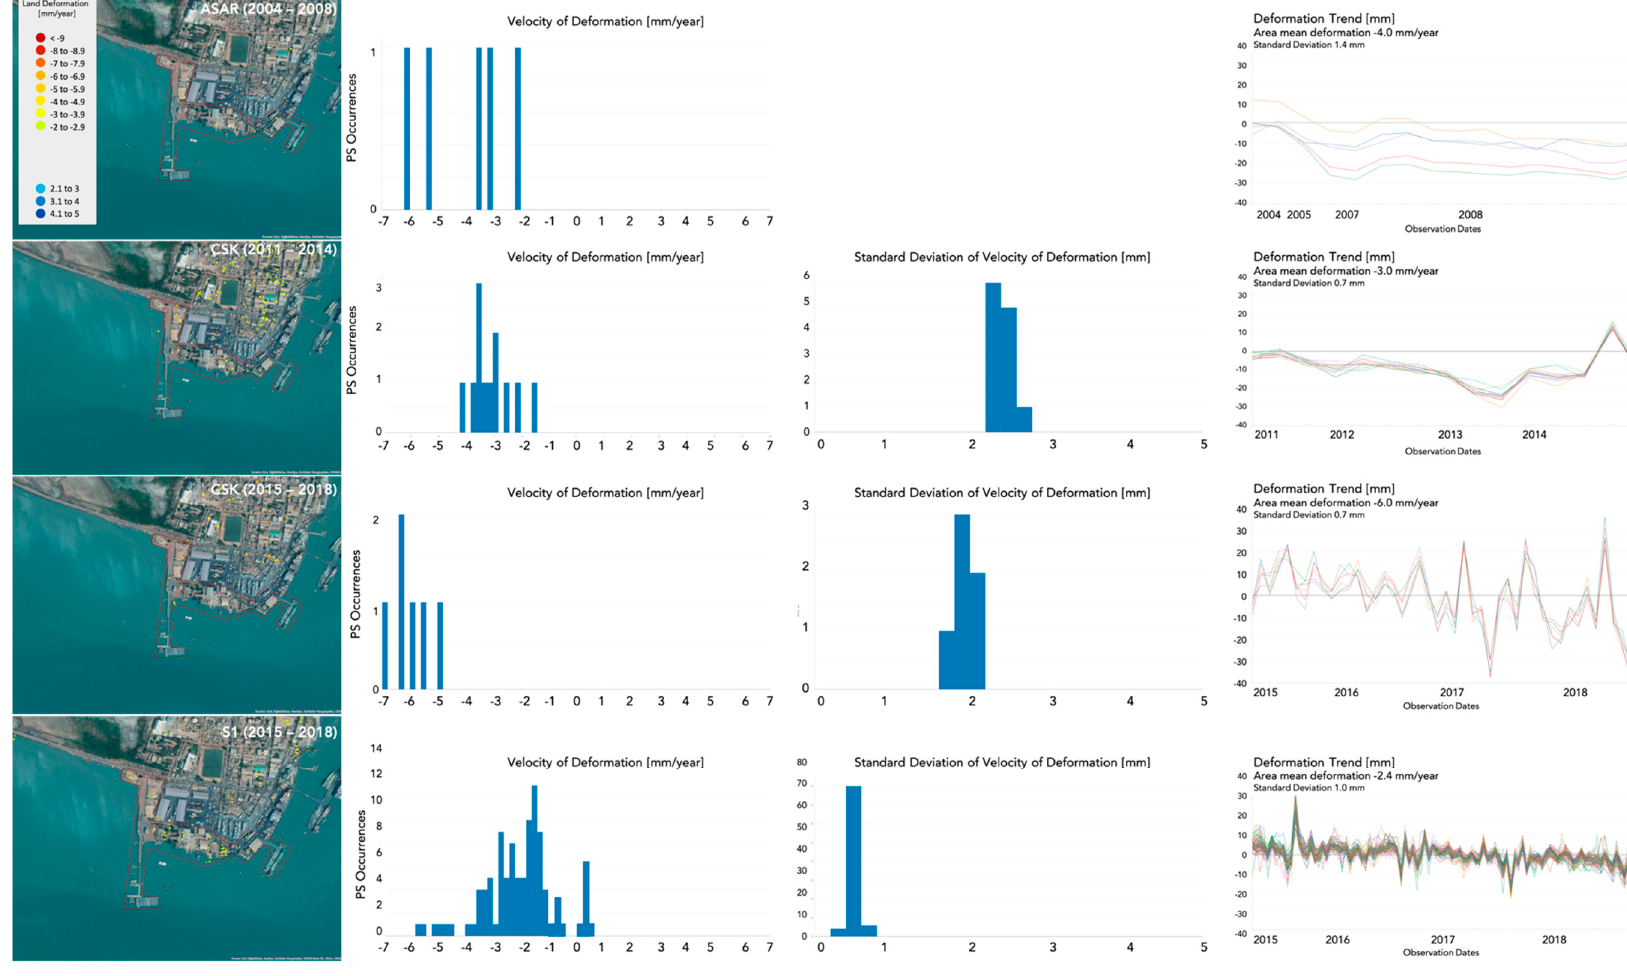
F igure 14. Banjul AOI 3. Figure 14. Banjul AOI